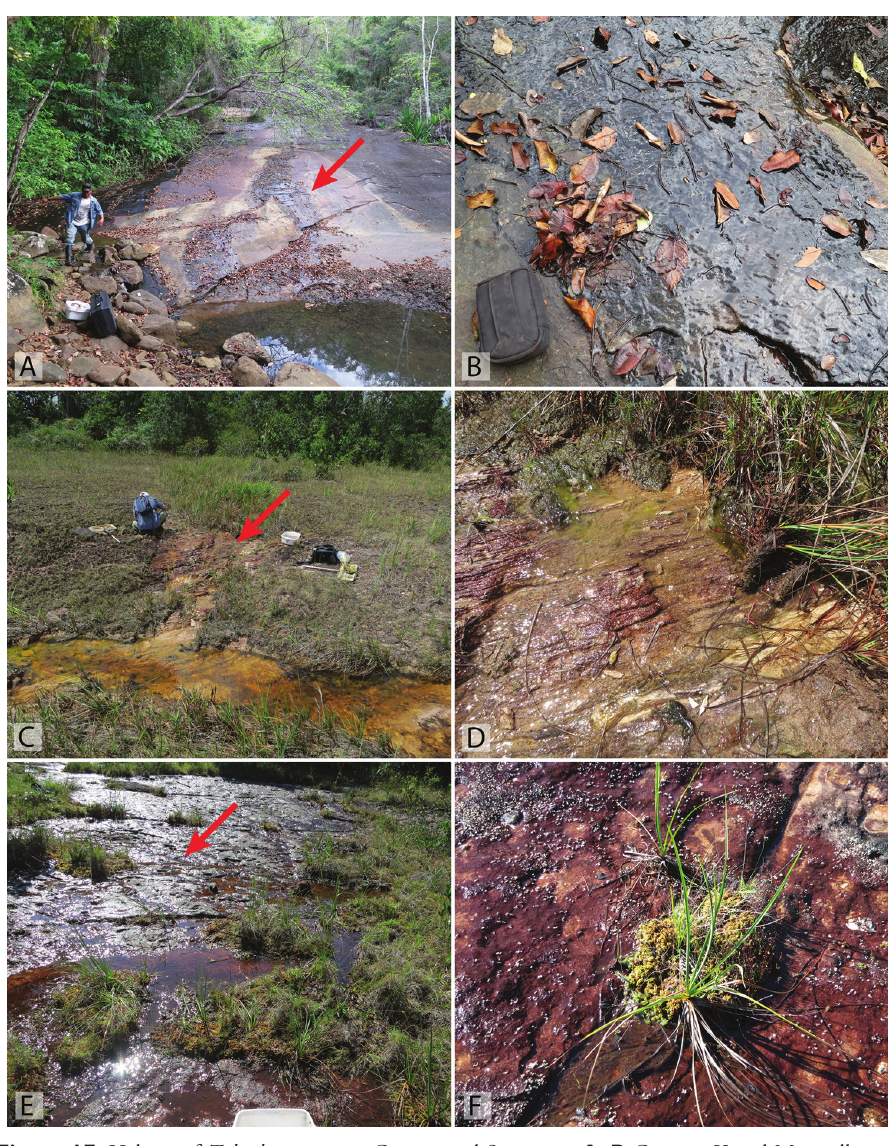
Figure 17. Habitat of Tobochares spp. in Guyana and Suriname. A–B Guyana, Kusad Mt., collecting event GY13-1027-03B, type locality for T. kusad sp. n. C–D Suriname, side of Kappel Airstrip, collect- ing event SR13-0824-02B, habitat of T. kasikasima E–F Suriname, summit of Tafelberg, Caiman Creek seepage, collecting event SR13-0819-01A, habitat of T. kasikasima . Red arrows point to example micro- habitats where specimens were